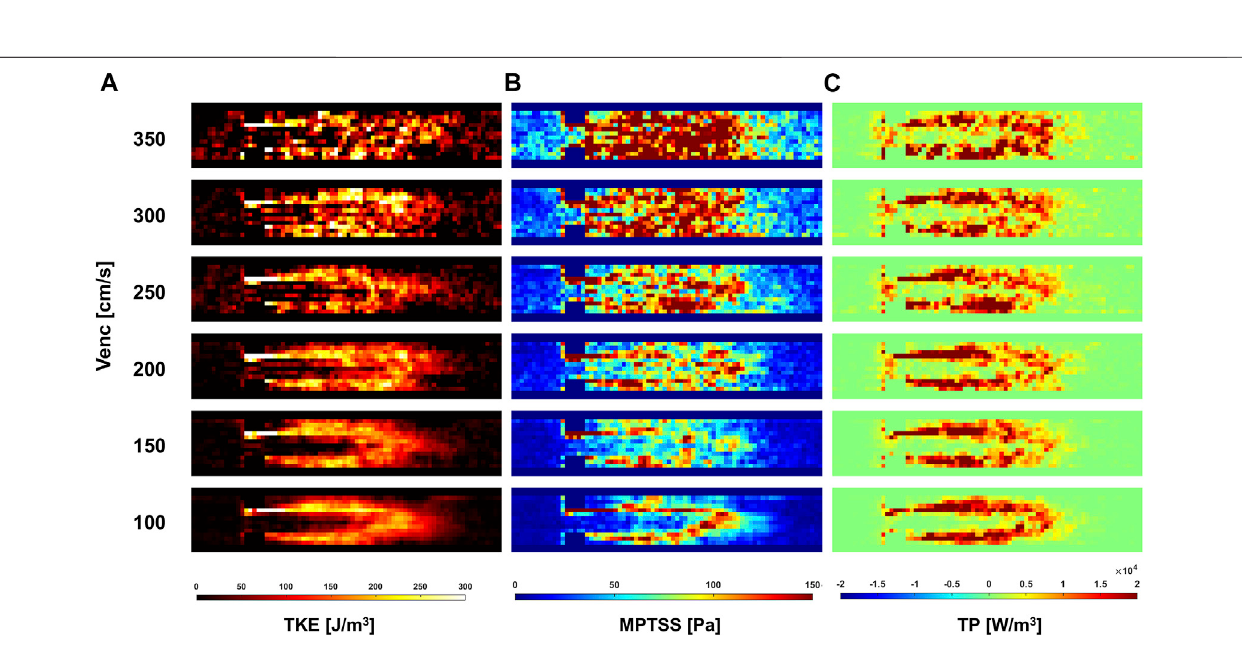
FIGURE 6 | Effect of Venc on (A) TKE, (B) MPTSS, (C) TP at peak